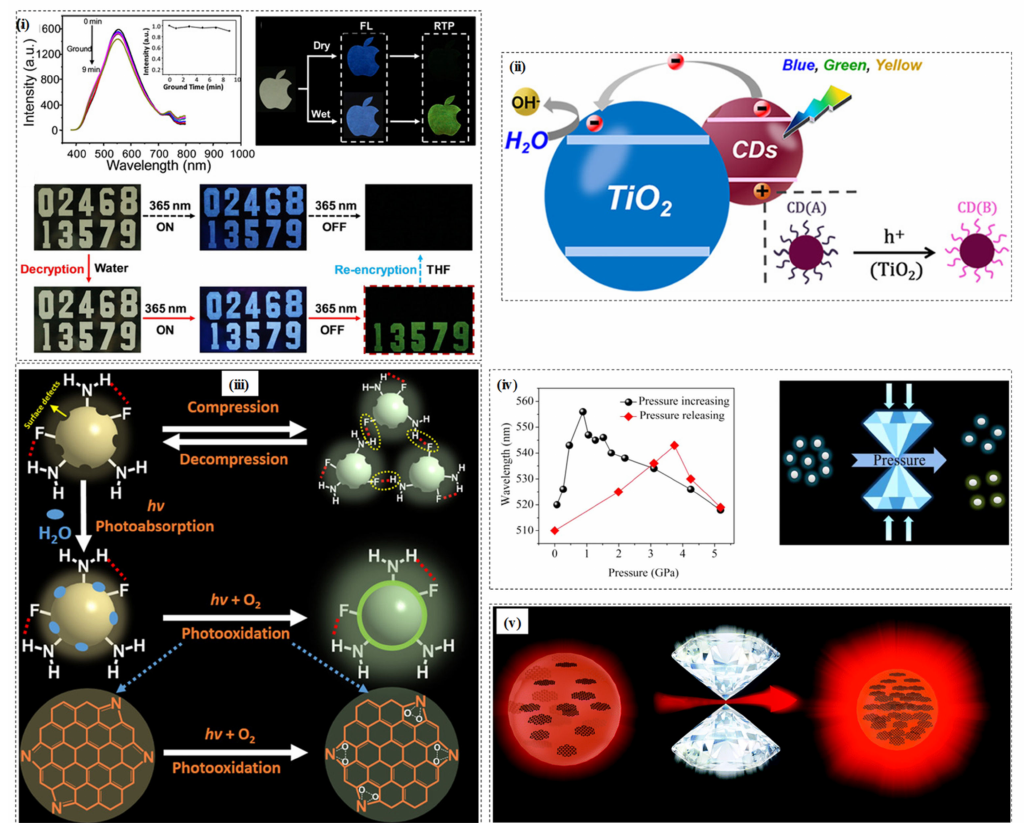
Figure 3. ( i ) Phosphorescent spectra of TA-CDs powder against time, illustration of the CDs with water-stimuli-responsive production and the encryption and decryption process [118] (Reproduced with permission). ( ii ) The photoenergy trans- formation in the IA-CDs/TiO 2 nanocomposite system [119]. (Reproduced with permission). ( iii ) Proposed mechanism of the pressure triggered fluorescence [19] (Reproduced with permission). ( iv ) PL peaks when pressure is released or increased (left) and proposed mechanism of piezochromic behaviour of N-CDs (right) [54] (Reproduced with permission). ( v ) Illustration of PL enhancement under high pressure [120] (Reproduced with